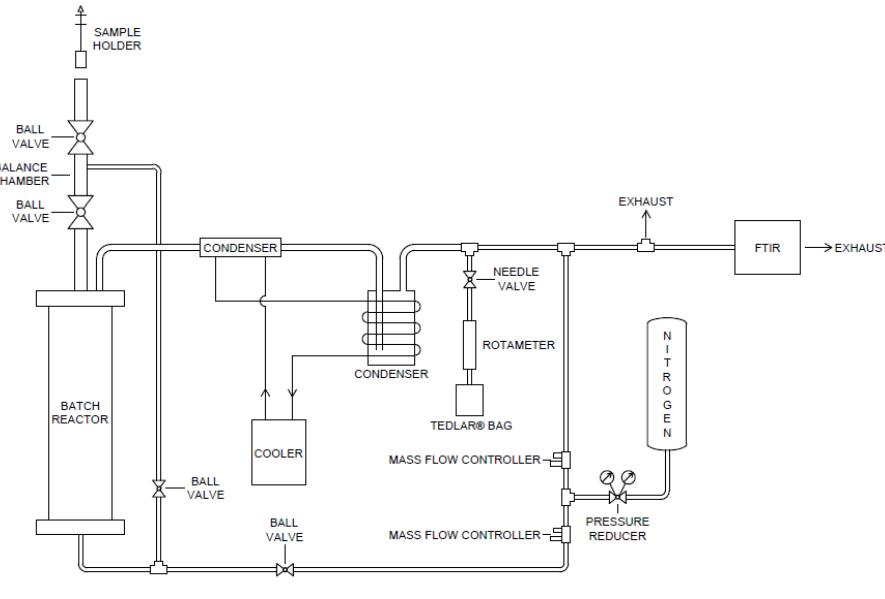
Fig. 1. Fixed bed reactor